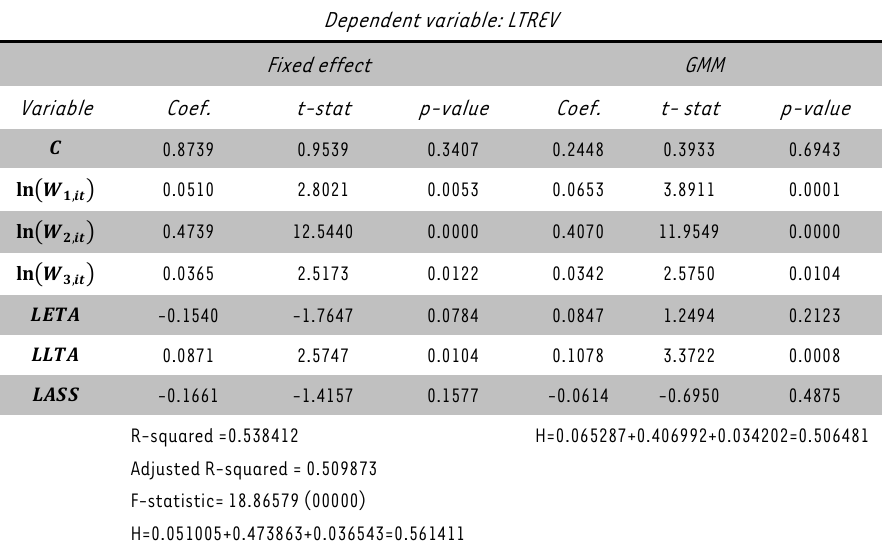
TABLE 6: H-Statistic test results: Testing competition Dependent variable: